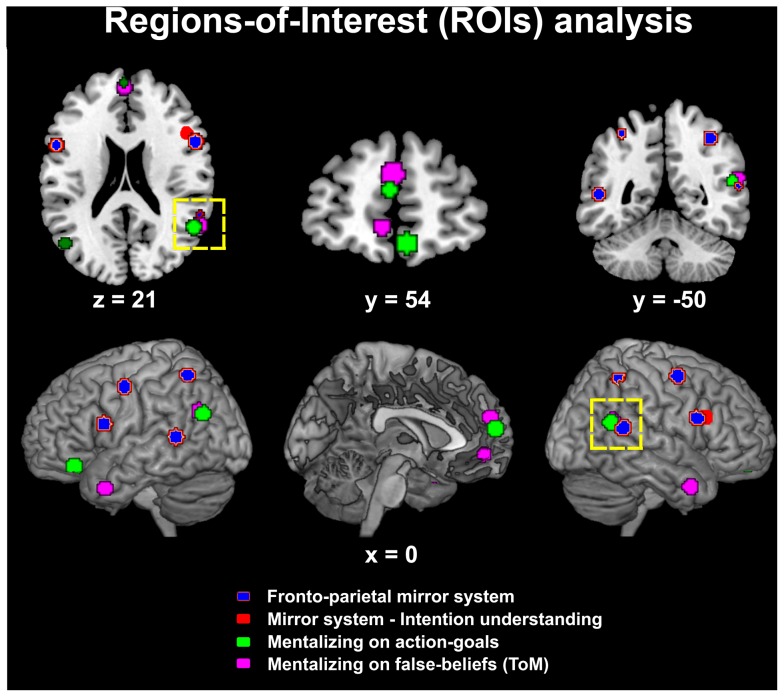
Regions-Of-Interest (ROIs) associated with social cognition.Graphical description of the regions involved in “action understanding” (i.e. mirror system; blue), “mentalizing on action goals” (green) and “Theory-of-Mind” (i.e. mentalizing proper, e.g. on false beliefs; violet) [15], along with intention understanding by the mirror system (red) [9], according to previously published papers [2], [9]. The regions were defined as 6-mm-radius spheres centred on the centre-of-mass of several previously reported MNI stereotactic coordinates for the right temporo-parietal-junction (TPJ), right dorsal and ventral premotor cortex (dPMC and vPMC), dorsomedial and ventromedial prefrontal cortex (dmPFC and vmPFC) [2] (see Methods and Tables S1, S2). A dashed yellow contour highlights the common involvement of the right TPJ in mirror motor resonance (blue), mentalizing on action goal (green) and mentalizing proper (i.e. on false beliefs, ToM; violet). The distance (in mm) from the origin of the MNI coordinate-system located in the anterior commissure is reported below each section.